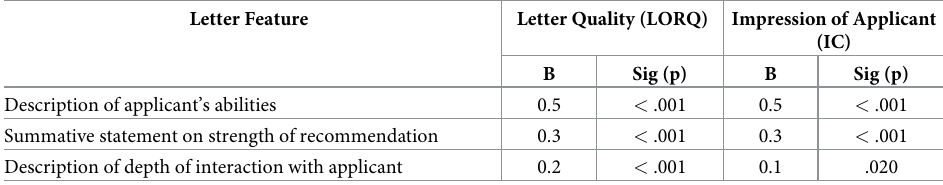
Table 1. Linear regression modelling of letter features predicting LORQ and